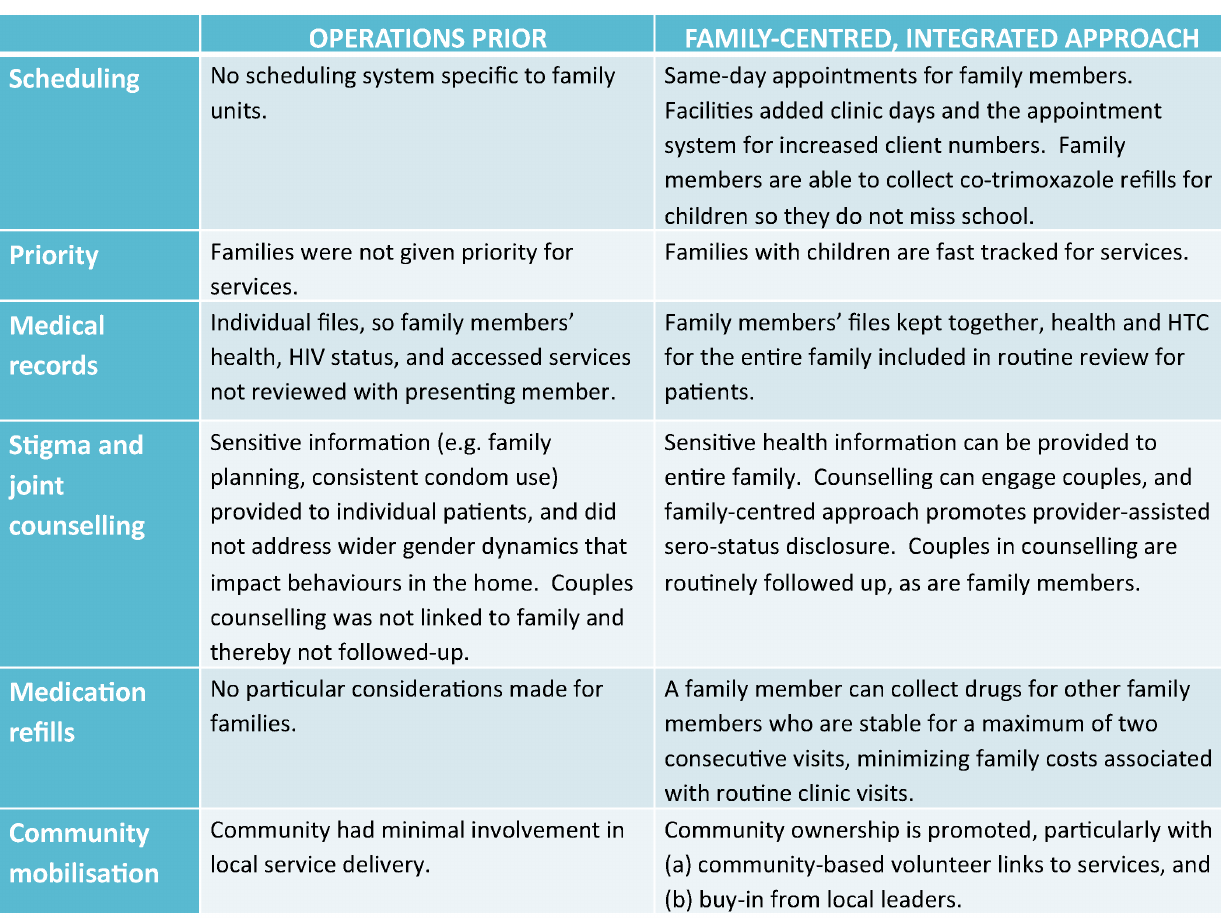
Figure 4. Service approach at health facilities before and after family-centred approach. Figure describes several service delivery components (e.g. scheduling, counseling, medication refills, and community engagement) before and after the family-centred approach. The figure demonstrates considerable effort to re-align the service approach to make it family-friendly, for example, same-day scheduling for families or fast- tracking families with children for services.